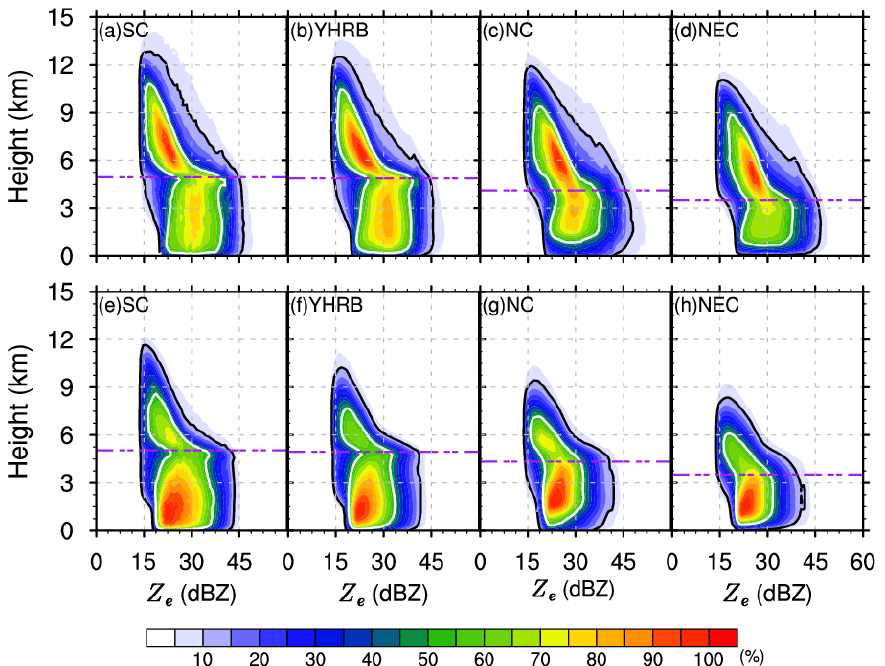
Figure 7. CFADs of Z e over ( a , e ) SC, ( b , f ) YHRB, ( c , g ) NC and ( d , h ) NEC for the LPFs (upper panel) and NLPFs (lower panel) during summer in the time period 2014–2021. The 10% and 50% contours are indicated by black and white solid lines, respectively. The bin sizes for Z e and height are 1 dBZ and 250 m, respectively. Purple lines denote the mean heights of the LH over four regions.